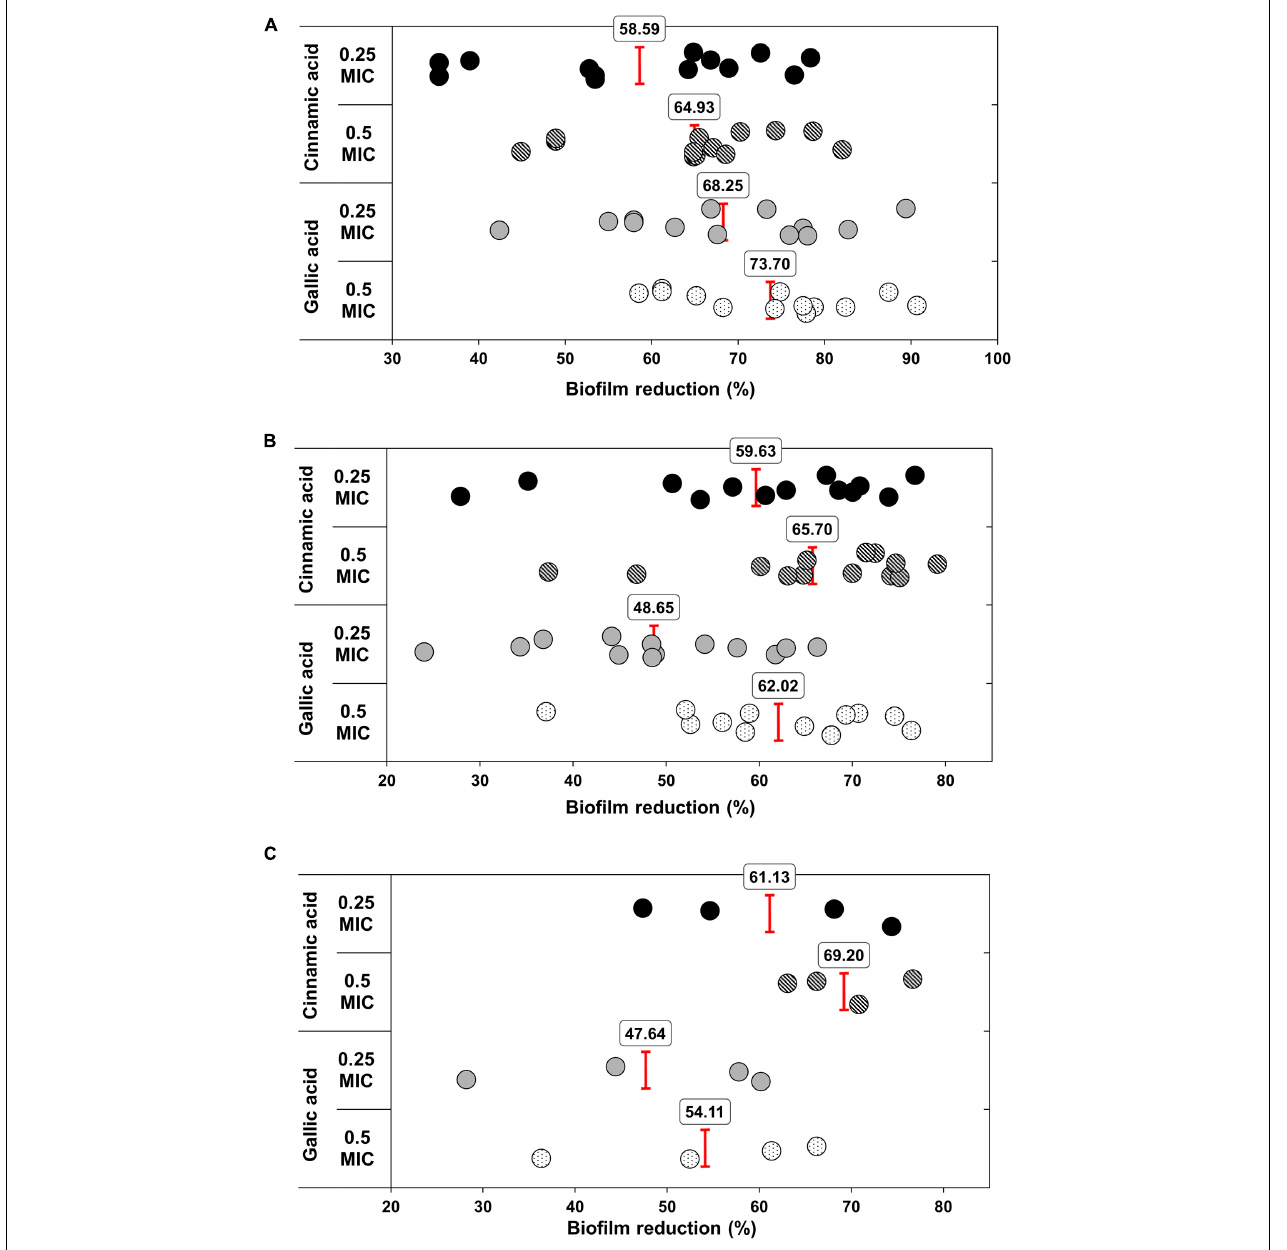
FIGURE 7 | Antibiofilm activities of sub-MICs of cinnamic and gallic acids. Scatter plot representing biofilm reduction (%) for each sample. Mean reduction percentages of 1/2 and 1/4 MICs cinnamic and gallic acids are illustrated against (A) strong biofilm formers [ANOVA F (3) = 6.4152, p < 0.05], (B) moderate